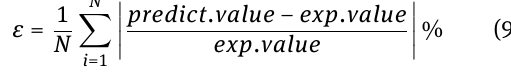
In the following Figures 12 and 13, a comparison be- tween experimental and predicted values of the normal- incidence sound absorption coefficient is reported for two different cases: with the presence of a 2 mm air gap (Fig- ure 12) and without the presence of the air gap (Figure